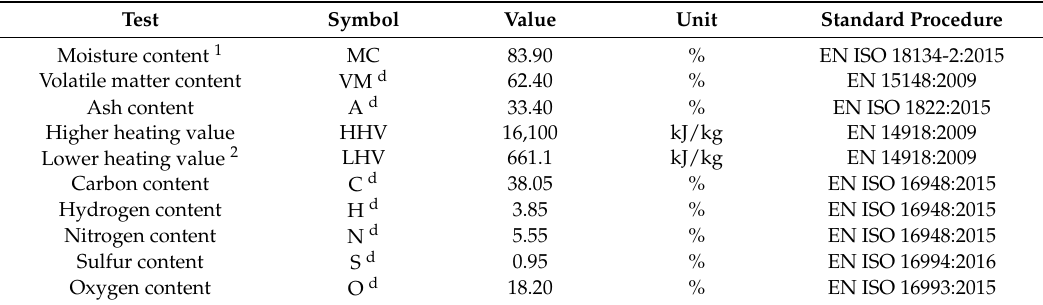
Table 1. Proximate and ultimate analysis of the sample of sewage sludge from Brzeg Dolny water treatment plant (after mechanical dewatering).